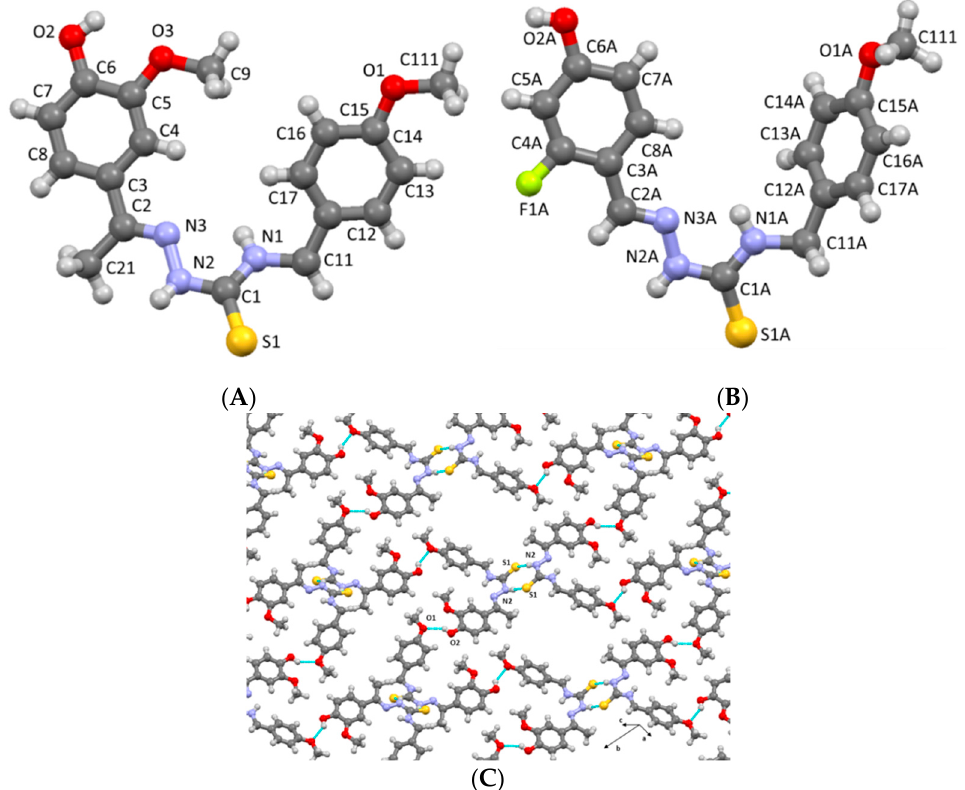
Figure 1. The molecular structures of HL 1 ( A ) and HL 2 ( B ), where only one of the two molecules present in the asymmetric unit is included, and the intermolecular association in HL 1 ( C ). Table 2. Selected bond lengths (Å) and angles (°).